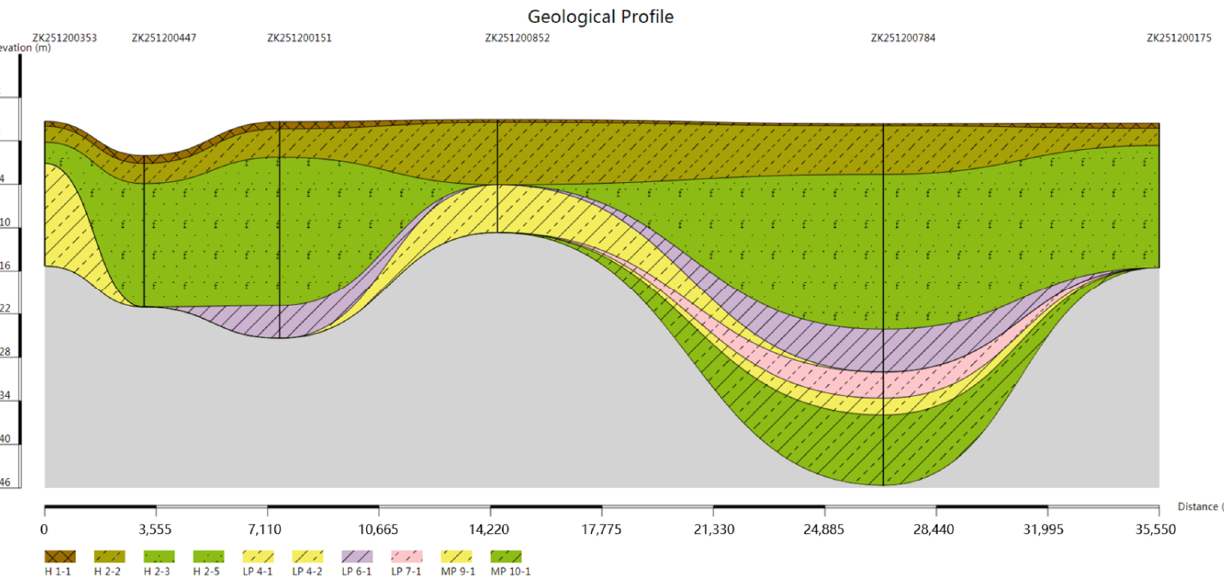
Figure 10. Geological profile IV corresponding to drilling line IV in Figure 7 by unique path method.